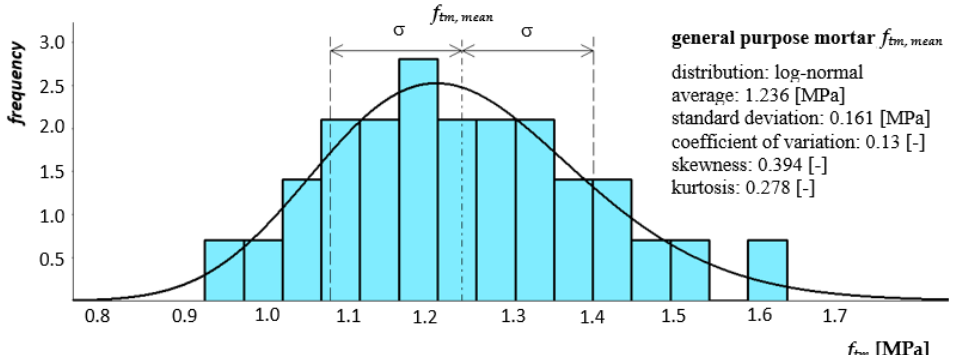
Figure 11. Histogram together with the approximate function of the tensile strength distribution when bending general purpose mortar as a component of a clay brick masonry pillar.